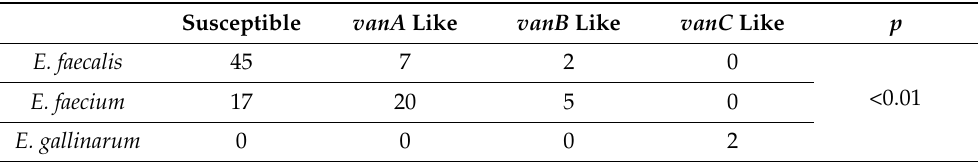
Table 3. Distribution of antibiotic resistance phenotypes of E. faecalis , E. faecium , and E. gallinarum on VITEK-2 antibiotic susceptibility testing (AST).